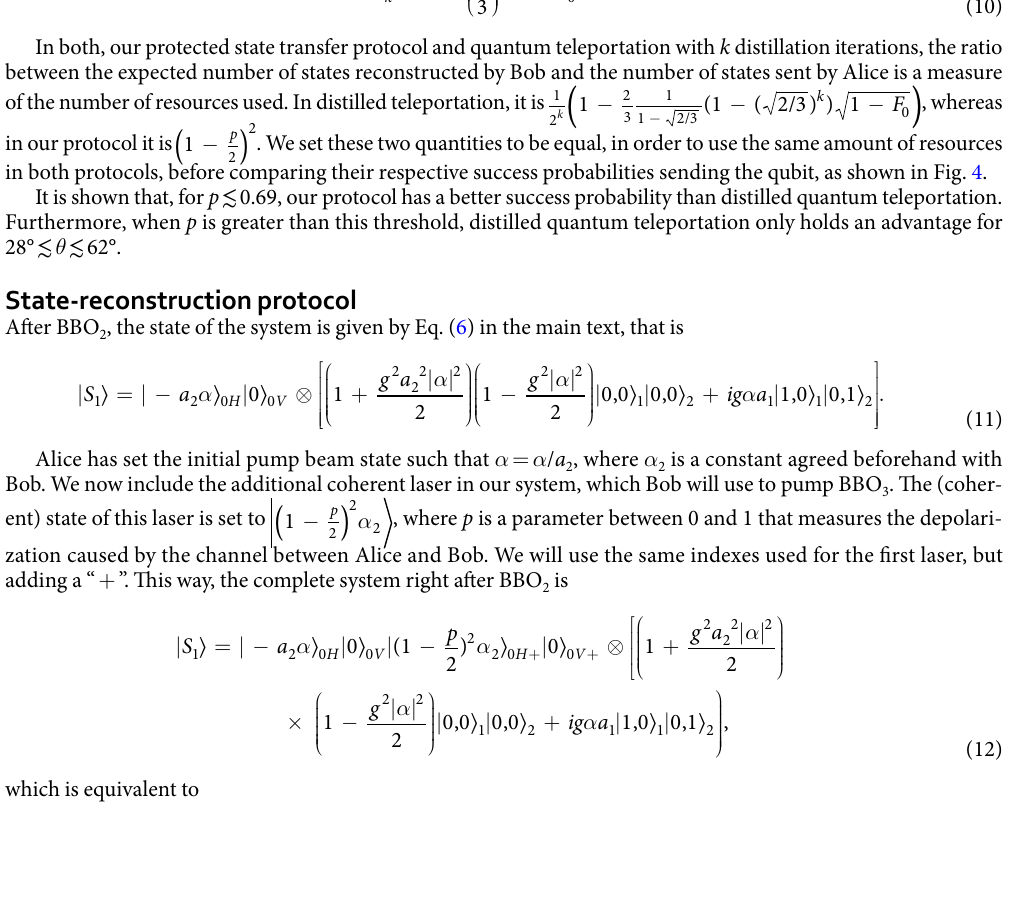
are discarded. To F 0